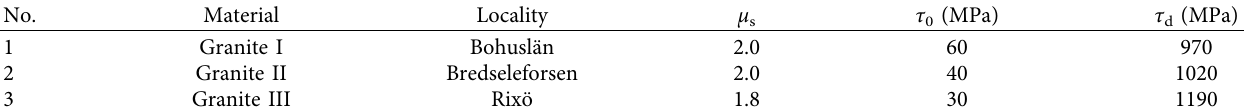
Table 1: Parameters of Lundborg criterion [13].